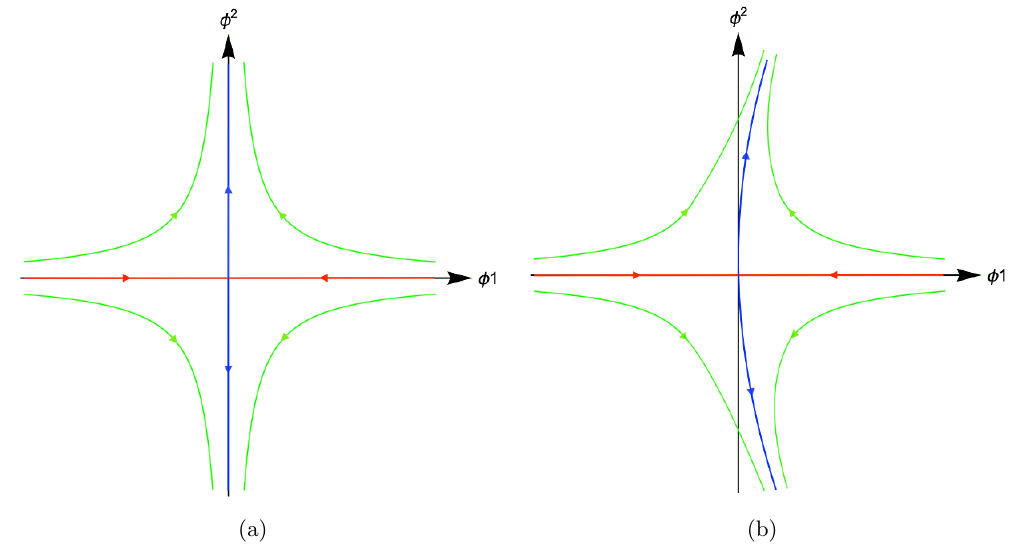
Figure 2 . The left (cid:12)gure represents (cid:13)ows associated with a W (+ (cid:0) ) of V ( (cid:30) ) as depicted in (cid:12)gure 1 or the (cid:13)ows from a W ( (cid:0)(cid:0) ) and m 2 < 0. The right (cid:12)gure represents a possible e(cid:11)ect of the non-linear terms which may or not 2 include non-analytic